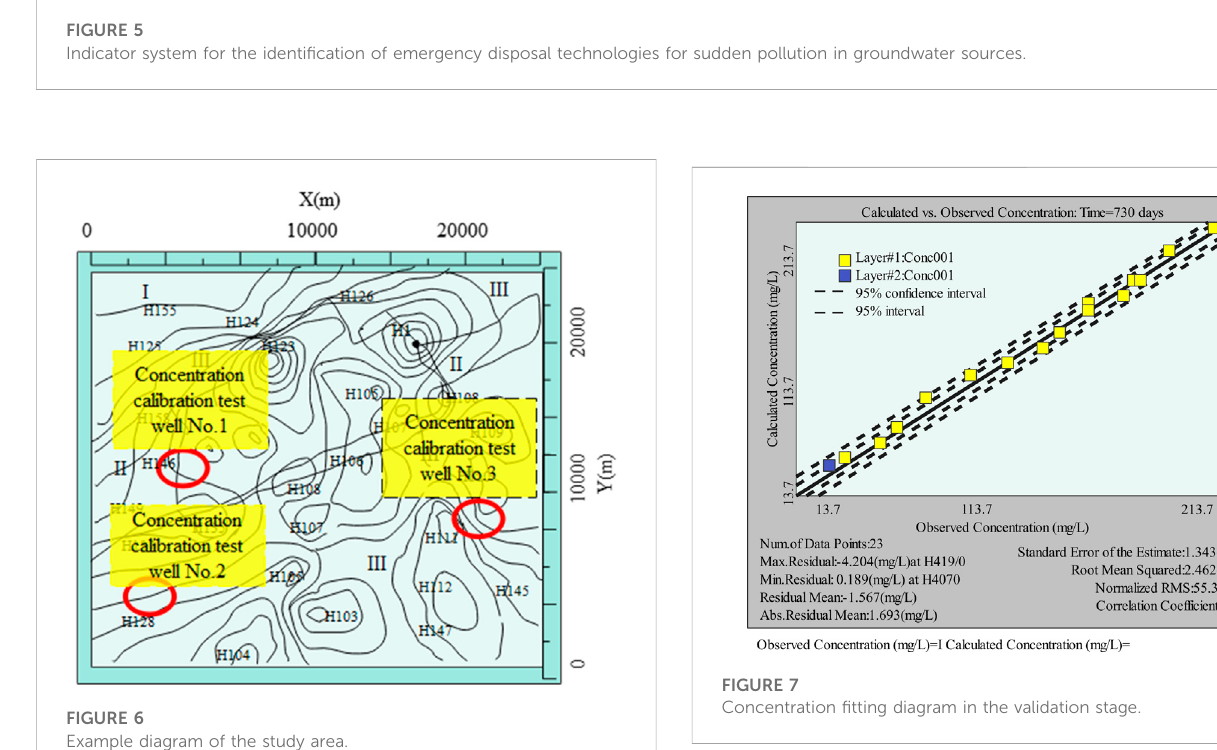
FIGURE 6 Example diagram of the study area.